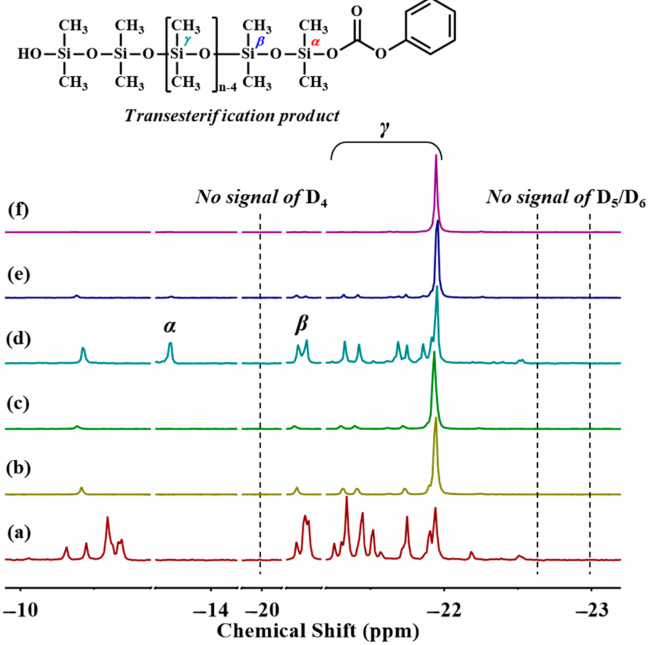
Figure 8. 29 Si-NMR spectra of ( a ) Silanol 5.3 , ( b ) Silanol 22.5 , and ( c ) Silanol 56.2 , as well as the final transesterification products of ( d ) Silanol 5.3 , ( e ) Silanol 22.5 , and ( f ) Silanol 56.2 reacted with DPC for 100 min at 180 ◦